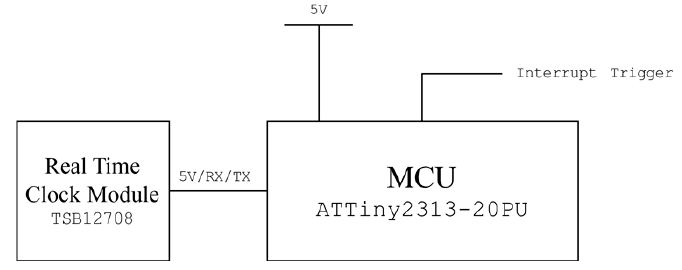
Figure 4. Circuit diagram of the designed off-line periodic polling device.